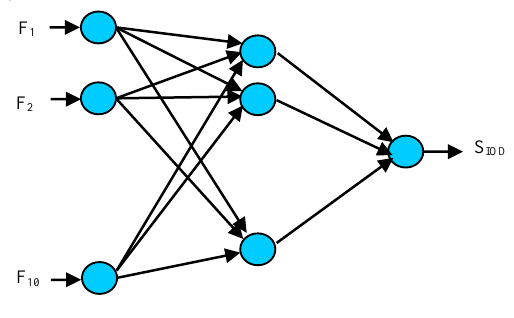
Figure 5. Structure of employed ANN to estimate similarity of main vessel to IOD vessels. Input F k is k th element of extracted feature vector corresponding to main vessel point, and S IOD is similarity value of this vessel point to inside of optic disc vessels.